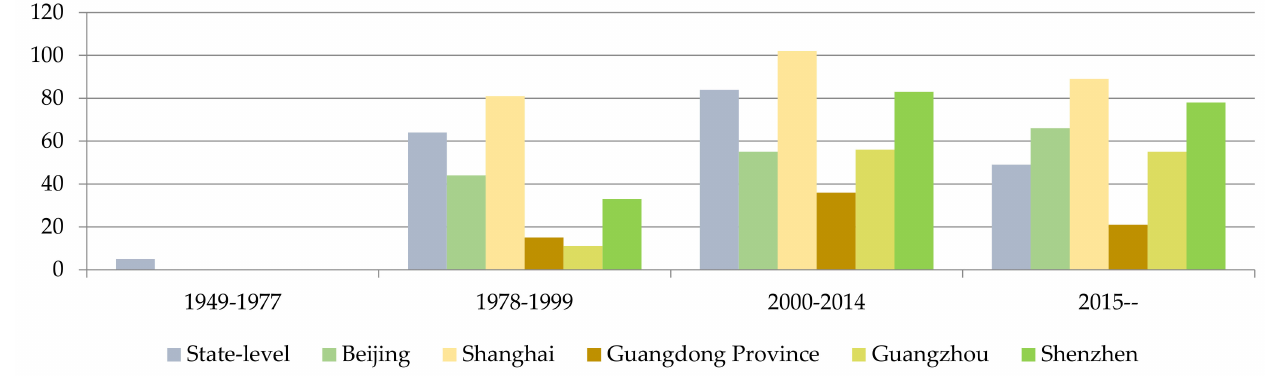
Figure 3. The year and quantity distribution in the four periods of China’s urban renewal policy. Second, after screening the texts, this study selected 216 closely related policy